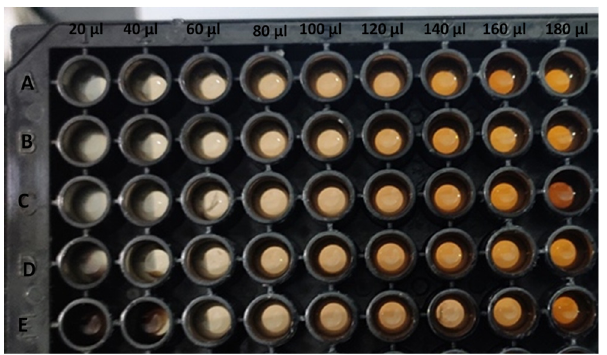
Figure 5. Image representing the minimum inhibitory concentration of AgNPs. ( A ) Enterobacter faecalis, ( B ) Gonococci spp., ( C ) Salmonella typhimurium, ( D ) Shigella flexneri, ( E ) Citrobacter spp.